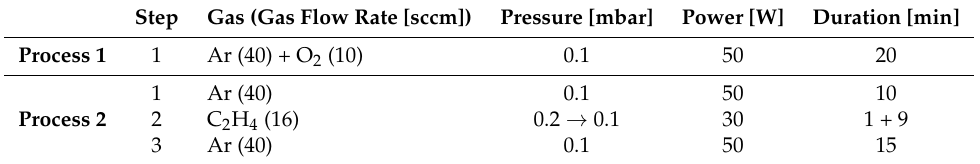
Table 1. Process parameters applied in the two plasma processes used to treat/coat the PEG substrates. Step Gas (Gas Flow Rate